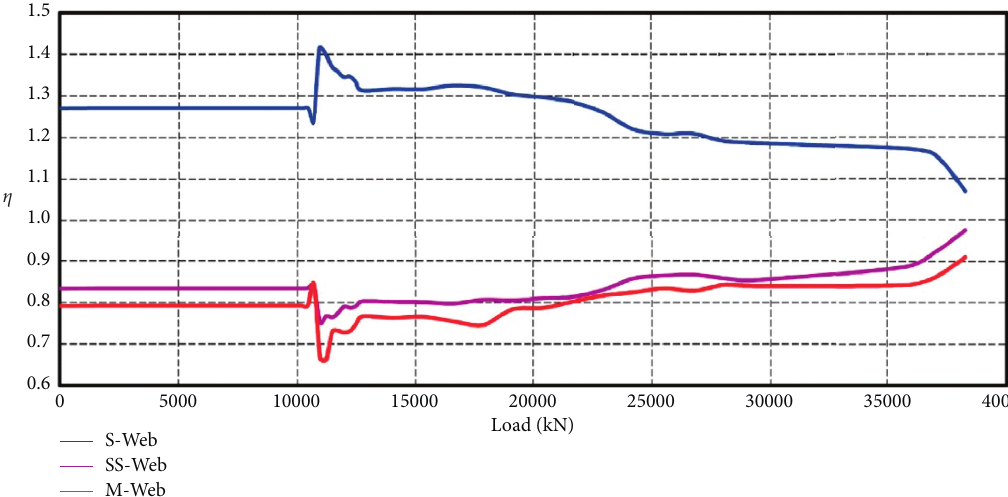
Figure 12: Shear force web redistribution in loading